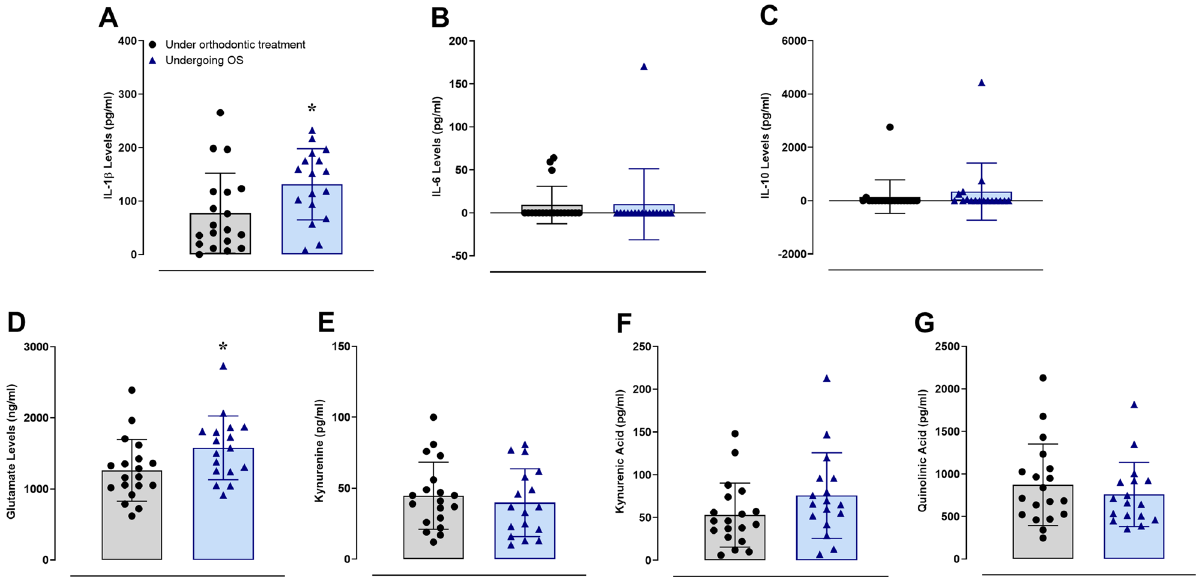
Figure 3. The salivary levels of IL-1β ( A ), IL-6 ( B ), IL-10 ( C ), glutamate ( D ), kynurenine ( E ), kynurenic acid ( F ), and quinolinic acid ( G ) in the control (n = 19) and test (n = 17) groups, according to the assessment by the DuoSet ELISA assay and UHPLC-MS. The Unpaired Student’s t-test was performed for all of the inflammatory markers, and the test group was significantly different from the control group (A and D) (* p < 0.05). Each column represents the mean ± SD, and the N of each group is depicted in the scatter dot